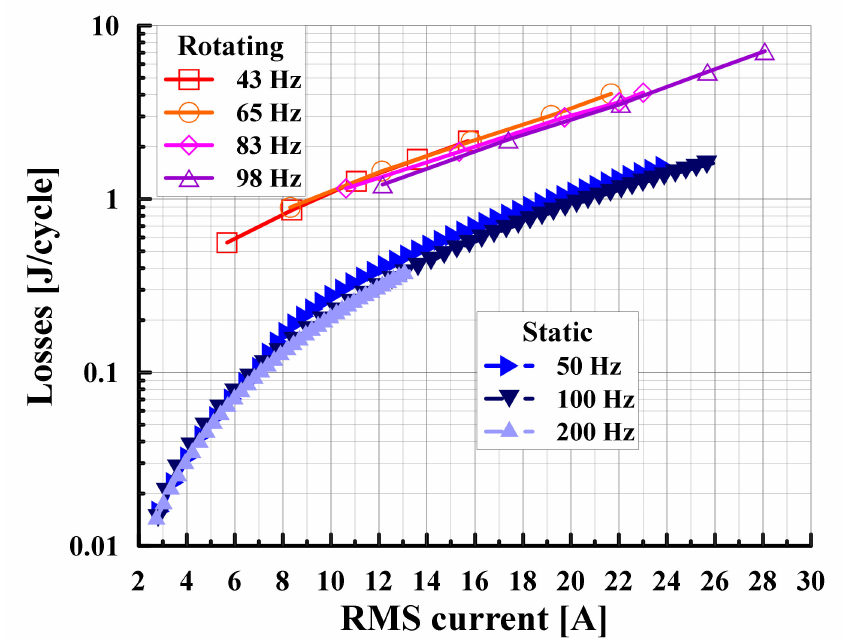
Figure 16. Measured sinusoidal current losses in the annular stator winding when operating in the generator mode (“Rotating”) and with the braked rotor